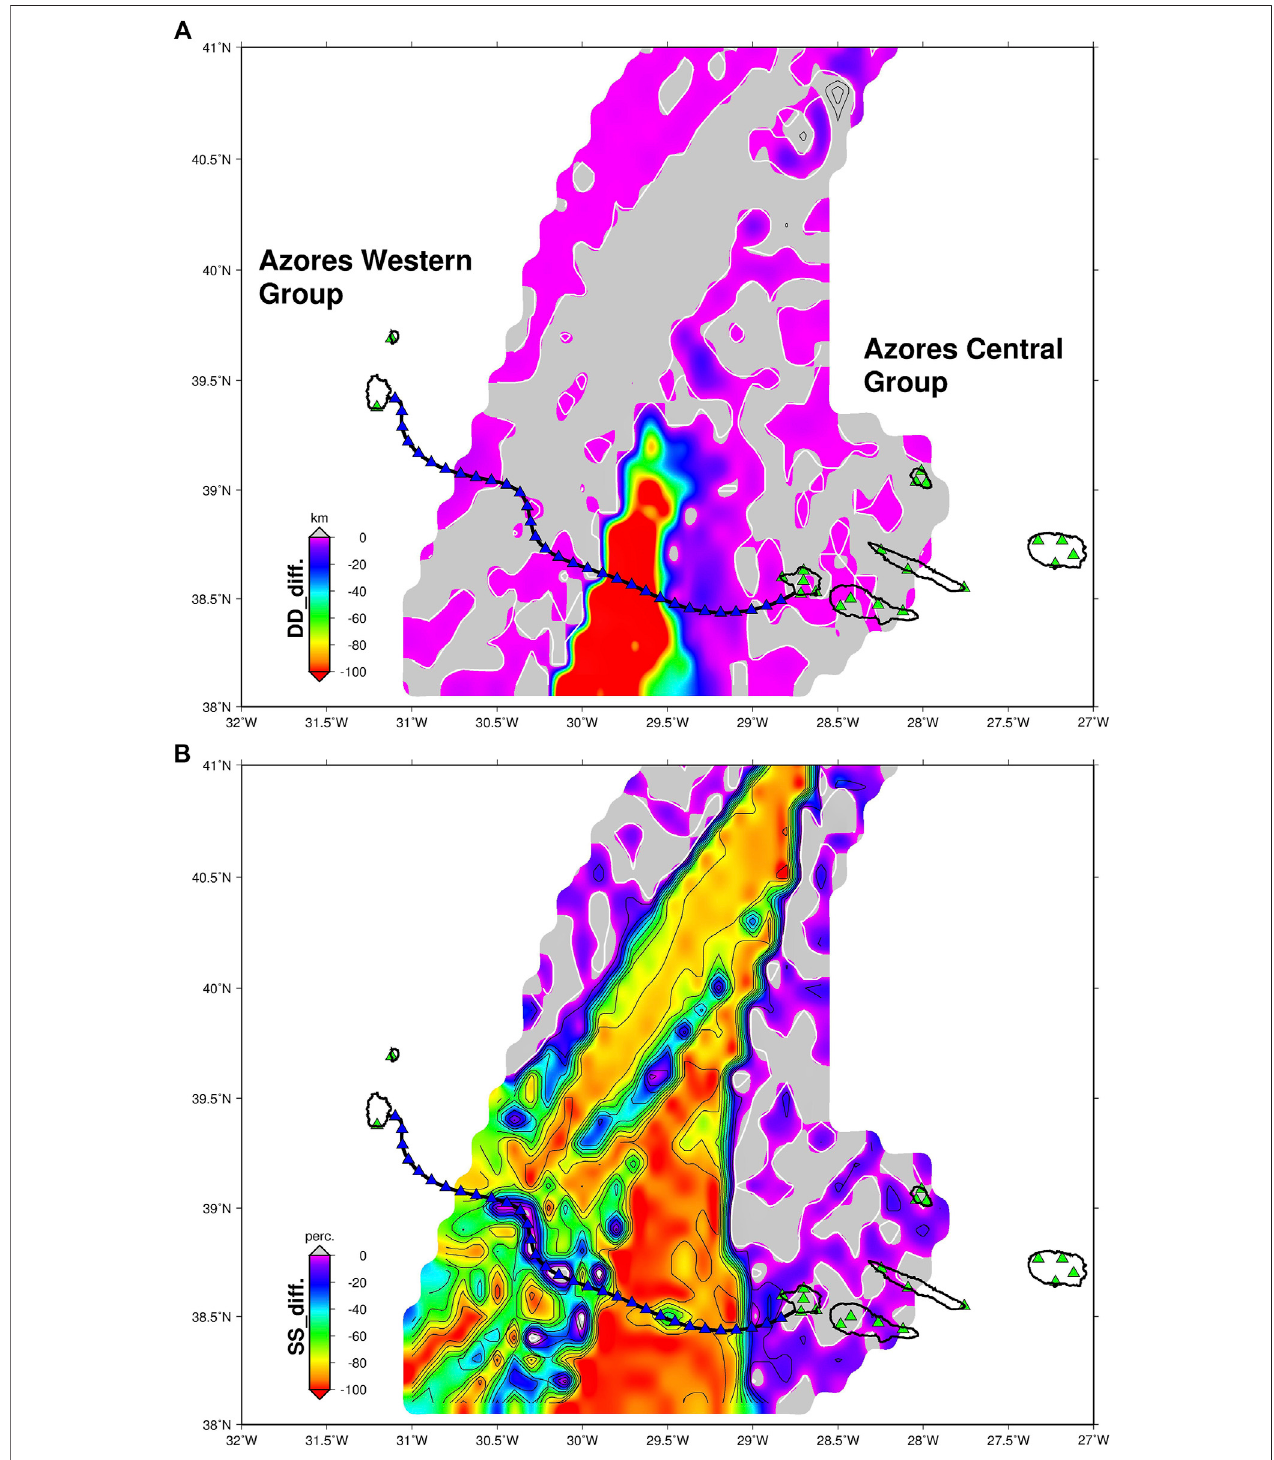
FIGURE 10 | Measure of the added value of the LI cable to the earthquake fast parameter determination using Monte-Carlo simulations. Green triangles show the land seismic stations while the cabled stations are shown as blue triangles. (A) Difference between “ land plus cabled ” and land only networks for the DD quality parameter. (B) Difference between “ land plus cabled ” and land only networks for the SS quality parameter, in %. On both images red areas show the domains were the difference is less than the maximum value, light grey areas show the domains were no improvement was observed.